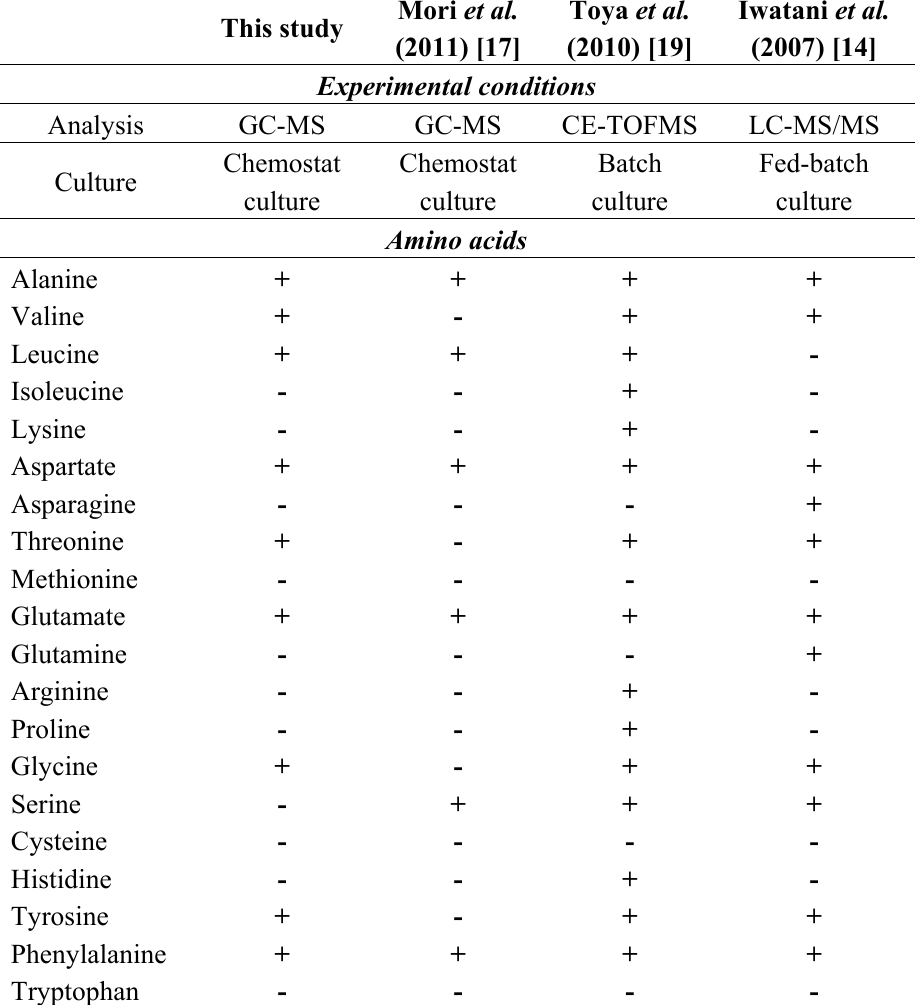
Table 2. Free amino acids measured in 13 C-metabolic flux analysis studies using E. coli